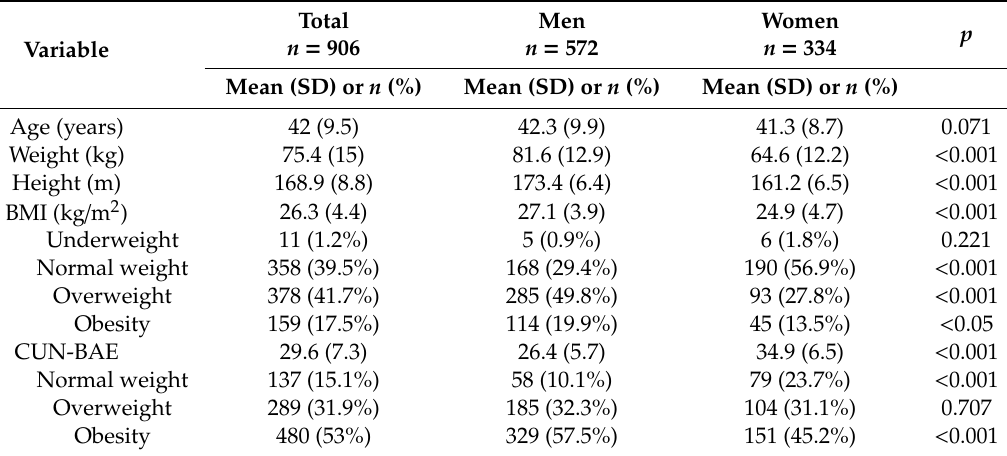
Table 1. Description of sample n 1